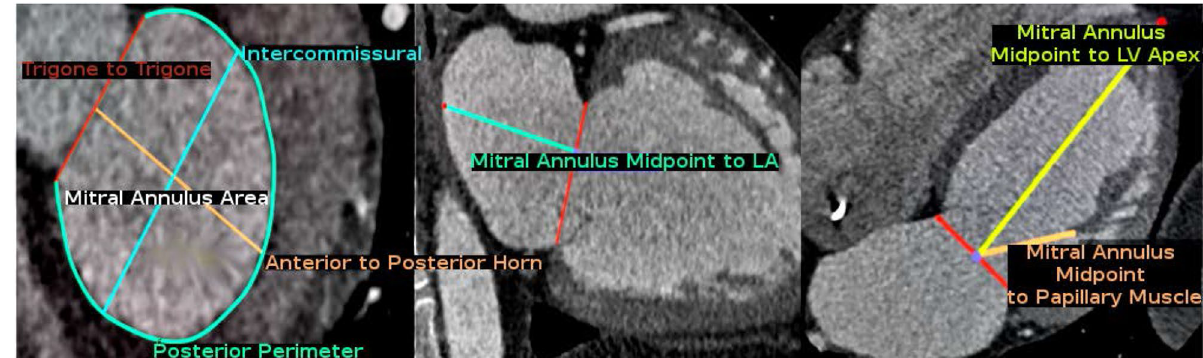
Figure 2. Illustration of the landmarks taken in the short axis, 2-chamber, and 4-chamber views of a CCT scan. Measurements were calculated from the analysis of the followings: (1) trigone to trigone diameter, (2) posterior perimeter, (3) mitral annulus area, (4) intercommissural diameter, (5) anterior to posterior horn diameter, (6) mitral annulus midpoint to head of the anterolateral papillary muscle (PM), (7) mitral annulus midpoint to head of the posteromedial papillary muscle (PM), (8) mitral annulus midpoint to endocardial border of the LV apex, (9) mitral annulus midpoint to epicardial border of the LV apex, and (10) mitral annulus midpoint to posterior wall of the left atrium